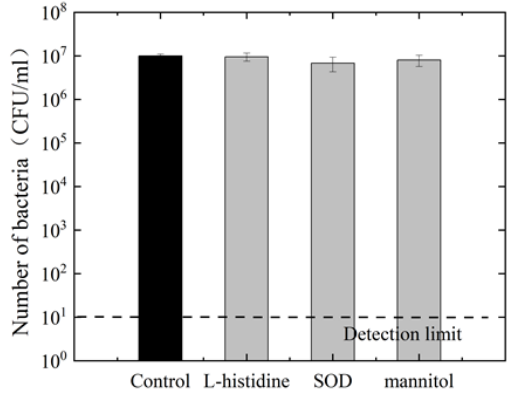
Figure 15. The short-lived ROS scavenger solutions alone had no appreciable sterilization effect on E. coli .